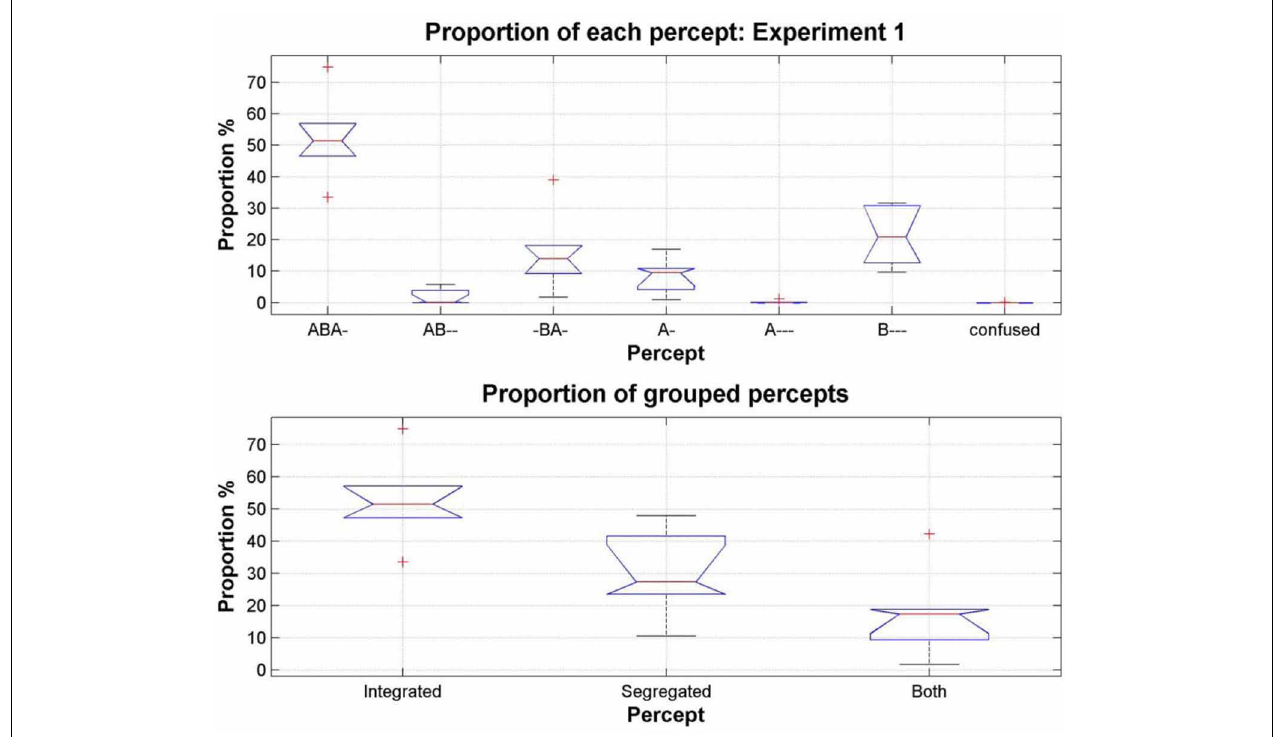
FIGURE 4 | Total proportion of each pattern, pooling the data from all participants, all sessions and all conditions in Experiment 1. On each box, the central red line is the median, the upper and lower edges of the boxes are the 25th and 75th percentiles, the whiskers extend to the most extreme data points considered not to be outliers; outliers are plotted individually as red crosses. Top: Proportion